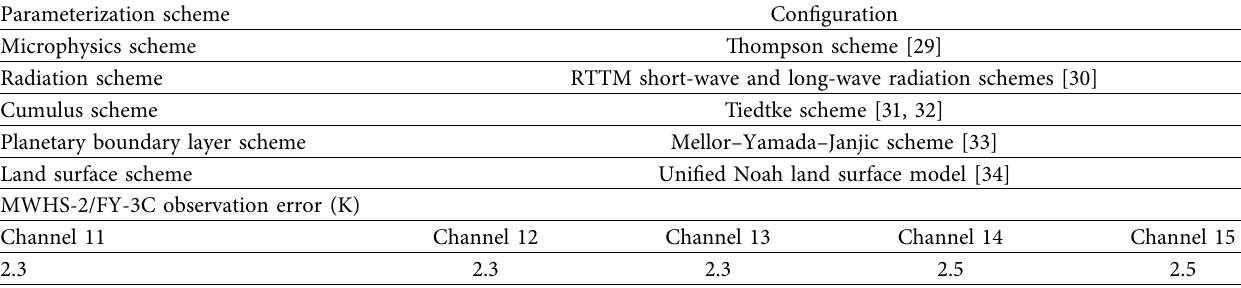
Table 2: The employed physical parameterization schemes and assigned observation errors for